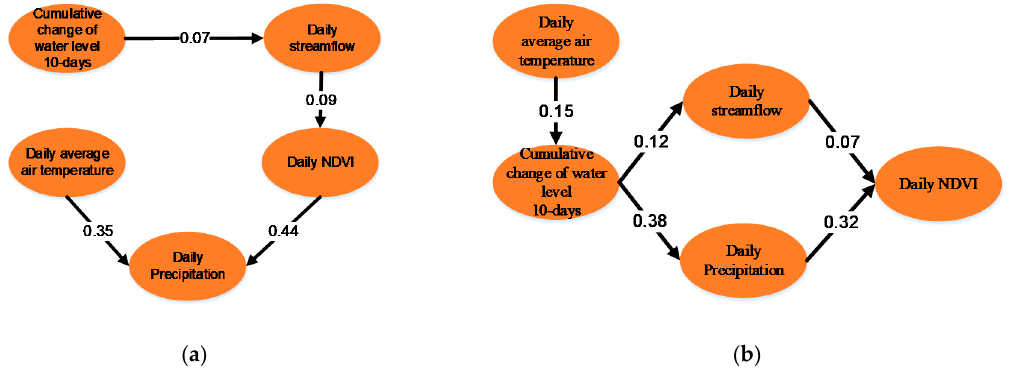
Figure 2. A deep-learning-based causal network inference method applied on the time series data of the Yichang and Beipei stations (preserving prominent causality linkages only). ( a ) Observed data causal network of the Yichang station ( b ) Observed data causal network of the Beipei station.